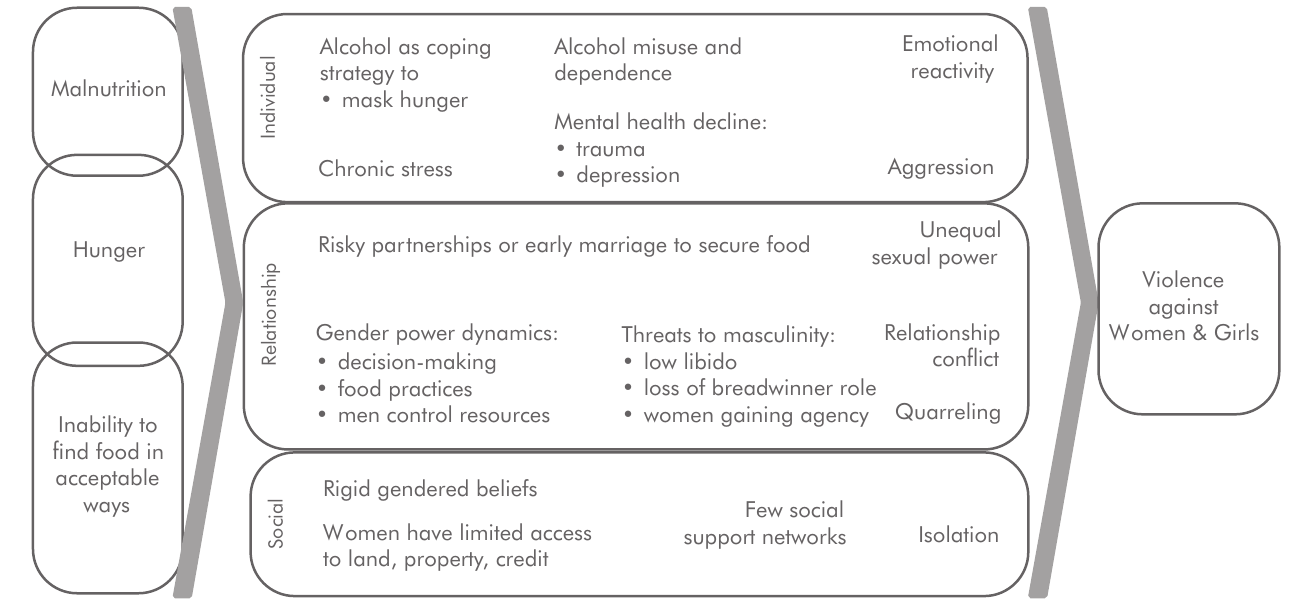
Fig 3. Conceptual framework of pathways between food insecurity and